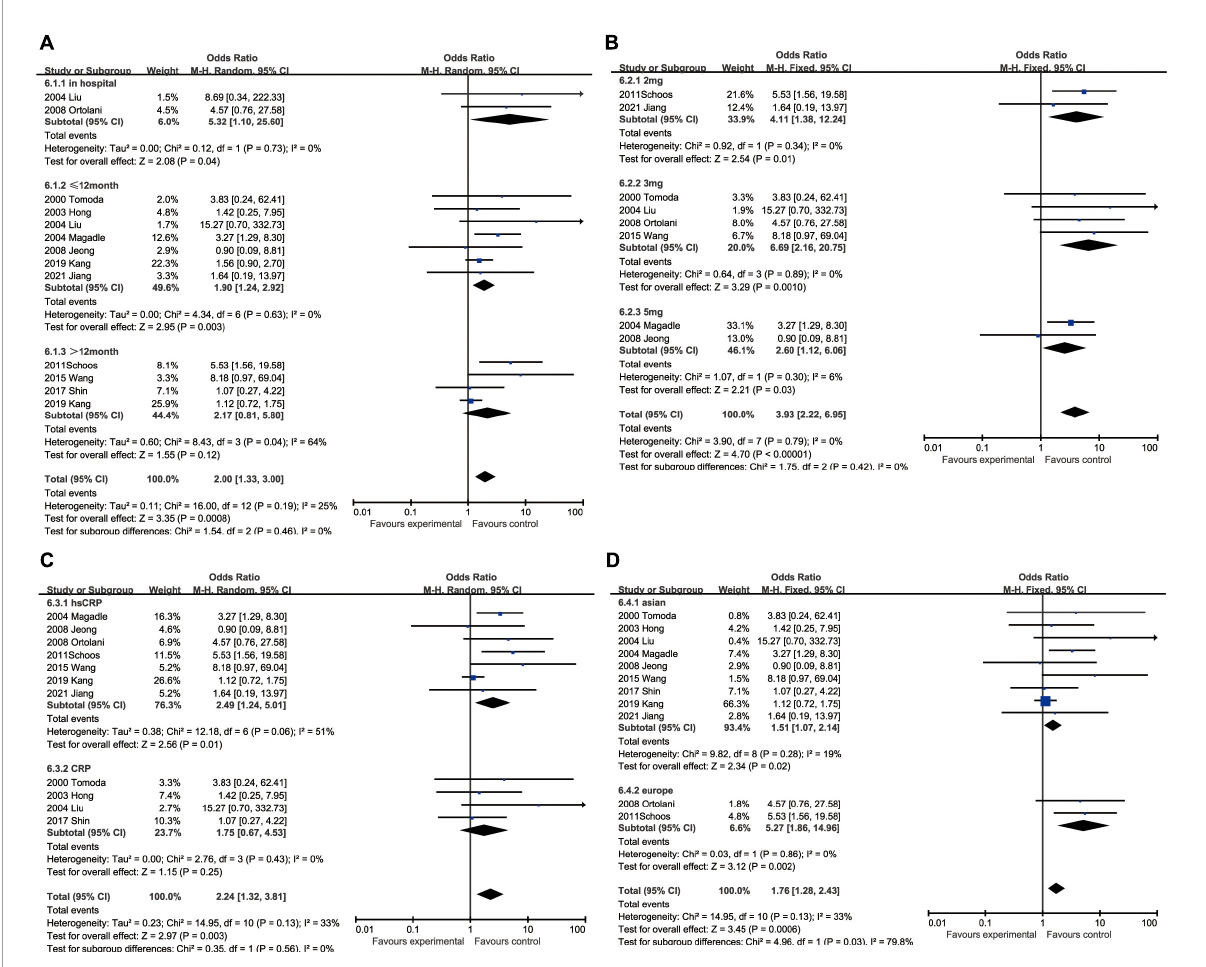
FIGURE7 Forrest plots of subgroup analysis assessing recurrent myocardial infarction associated with increased CRP: (A) subgroups based on cut-off value of hsCRP; (B) subgroups based on CRP and hsCRP; (C) subgroups based on ethnicities; and (D) subgroups based on